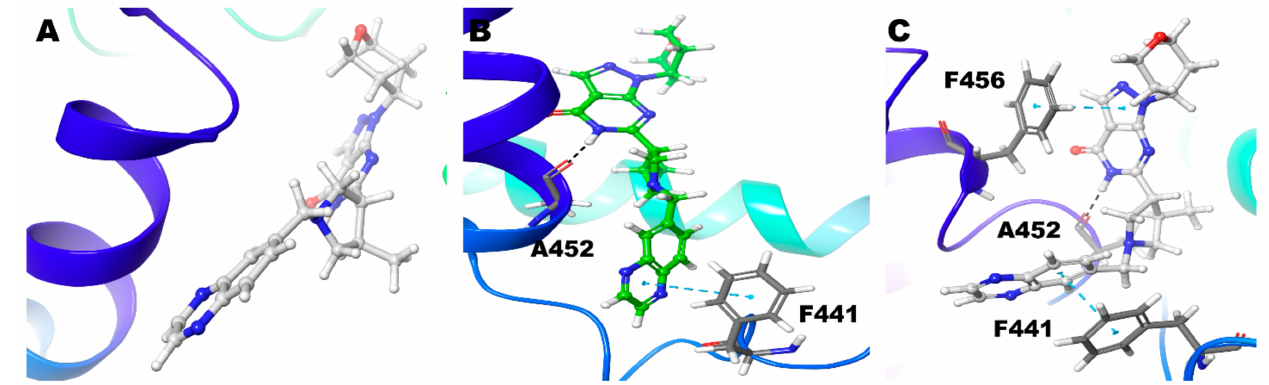
Figure 10. Non-bonded interactions of Compound 5 in ( A ) PDE9 Zn/Mg ( B ) PDE9 Mg/Mg ( C ) PDE9 Zn/Zn.